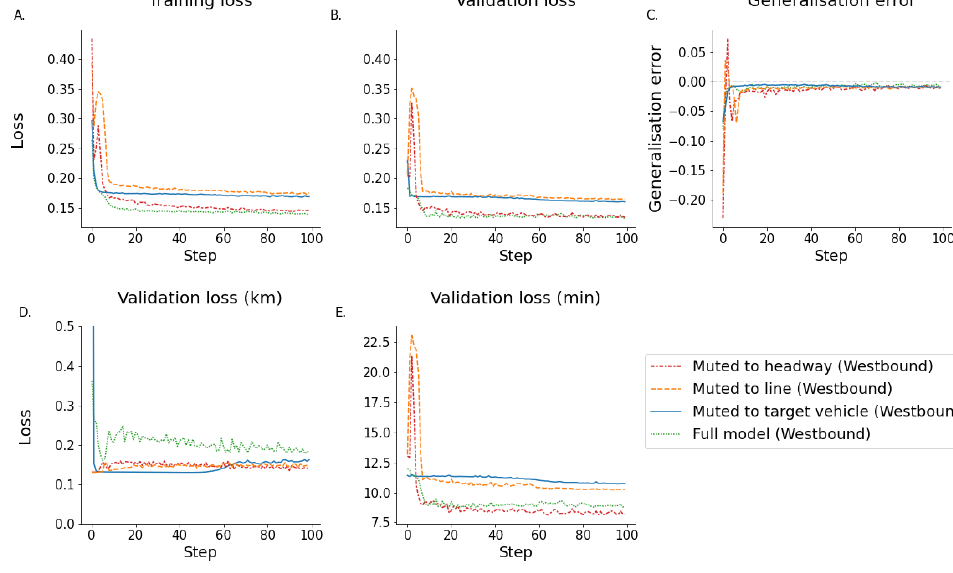
Figure 13. Training and validation of the westbound direction for all muted models in comparison to the model with access to the entire network data.In the example of this direction the best validation loss was achieved by the model incorporating the entire network data. ( A ) shows the training loss. ( B ) shows the validation loss. ( C ) shows the generalisation error calculated by subtracting the training error from the testing error. ( D ) shows the estimated validation error in km. ( E ) shows the estimated validation loss in minutes. (Note that subfigure ( D ) has a truncated y axis for illustration